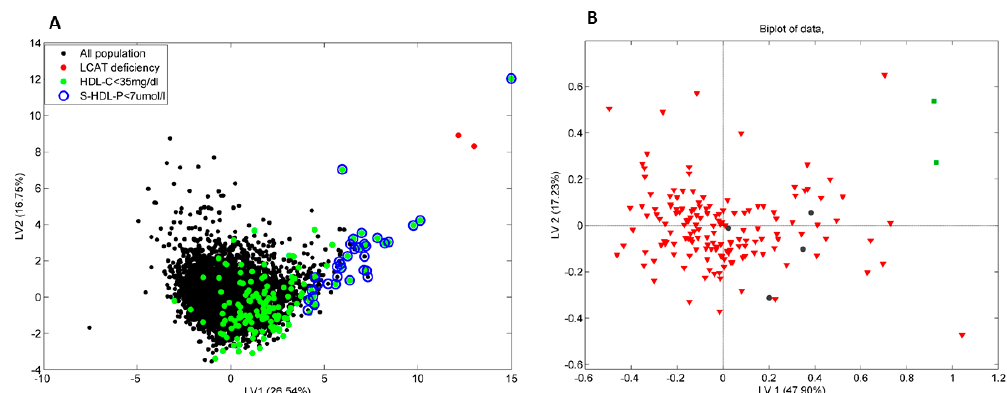
Figure 4. Partial least square discriminant analysis (PLS-DA) models for LCAT deficiency classification, based on NMR Lipoprotein profile data. ( A ) Scores plot from a PLS-DA model designed for LCAT deficiency identification among the general population. The individual projection on the first two latent variables is indicated with a black dot for individuals with HDL-c ≥ 35 and small HDL particle concentration > 7umol/L, with a red dot for LCAT deficiency patients, with a green dot for HDL-C >35 mg/dL, and a blue circle if the small HDL particle concentration is < 7umol/dL. ( B ) Biplot of the PLS-DA model designed for LCAT deficiency identification among patients with very low levels of HDL cholesterol. The individual projection on the first two latent variables is indicated with a red triangle for low HDL-C patients ( n = 150 individuals), and with a green square for two individuals (2nd and 3rd cases) with LCAT deficiency.